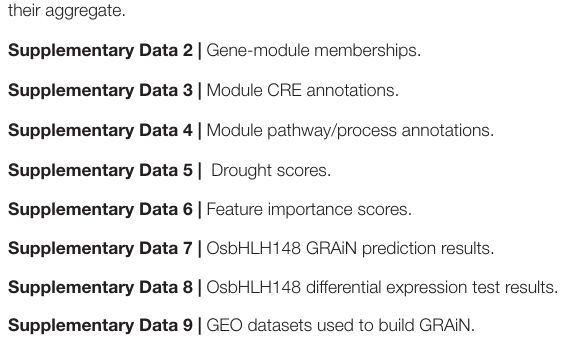
Supplementary Figure 5 | Predicted drought scores in relation to the pan-genome of rice. Boxplots showing drought score distributions of (A) core TF, (B) indica dependent TFs, and (C) japonica dependent TFs. Supplementary Table 1 | Evaluation of different network inference methods. Algorithms were tested for their ability in recovering putative cis elements listed in CIS-BP database in the promoters of their predicted target genes. Supplementary Table 2 | Primers used in the study. Supplementary Data 1 | Top 500,000 edges inferred by the ensemble and their aggregate. Supplementary Data 2 | Gene-module memberships.